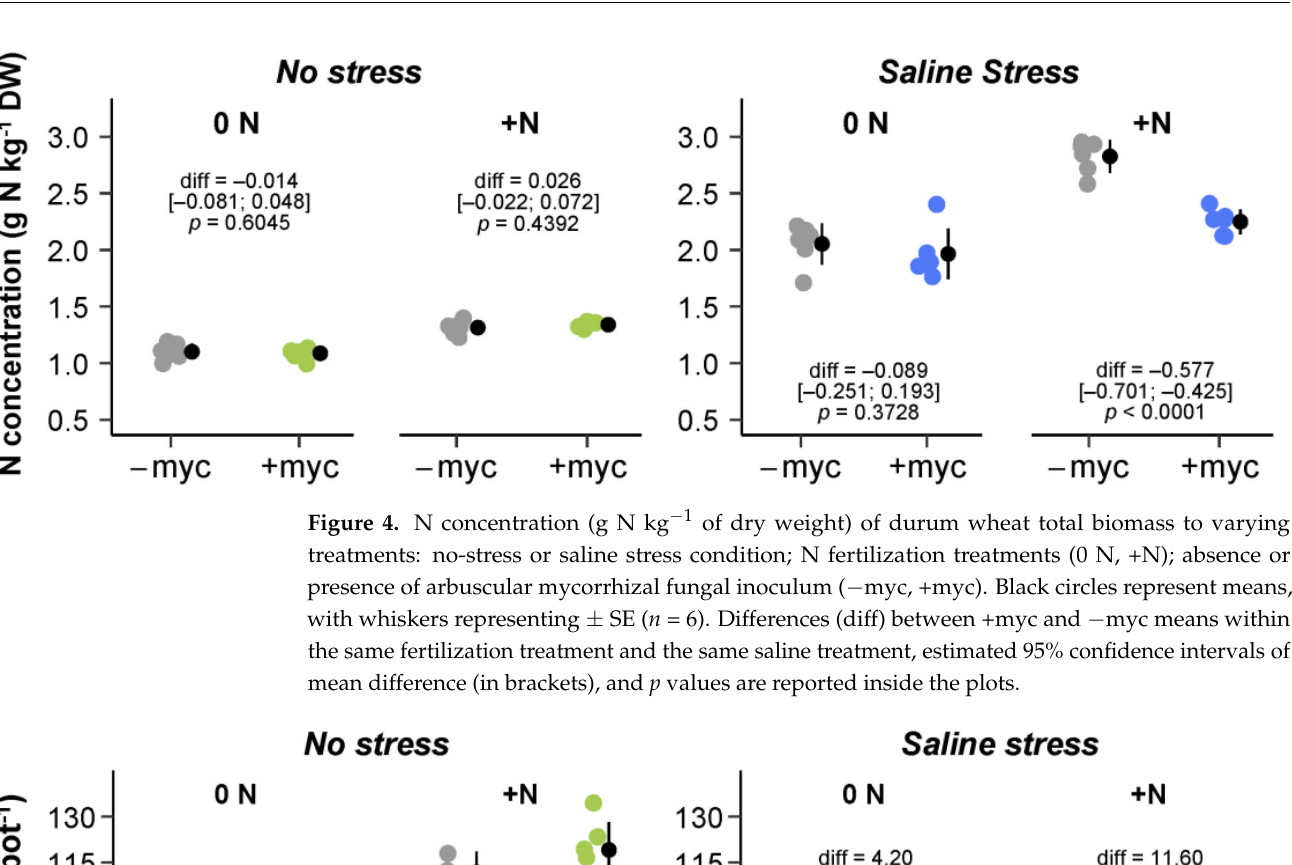
Figure 6. 15 N fertilizer recovery (%) of durum wheat to varying treatments: no-stress or saline stress condition; absence or presence of arbuscular mycorrhizal fungal inoculum ( − myc, +myc). Black cir- cles represent means, with whiskers representing ± SE ( n = 6). Differences (diff) between +myc and − myc means within the same saline treatment, estimated 95% confidence intervals of mean differ- ence (in brackets), and p values are reported inside the plots. As expected, the saline stress markedly reduced Water Use Efficiency (WUE) com- pared to the unstressed control (on average, 3.08 and 1.52 g DM per litre, respectively, for no stress and stress treatment; Figure 7). The mycorrhization has determined relevant ef- fects on this parameter only for plants subjected to stress and fertilized (+45%); in all other conditions, no changes were observed on the WUE.